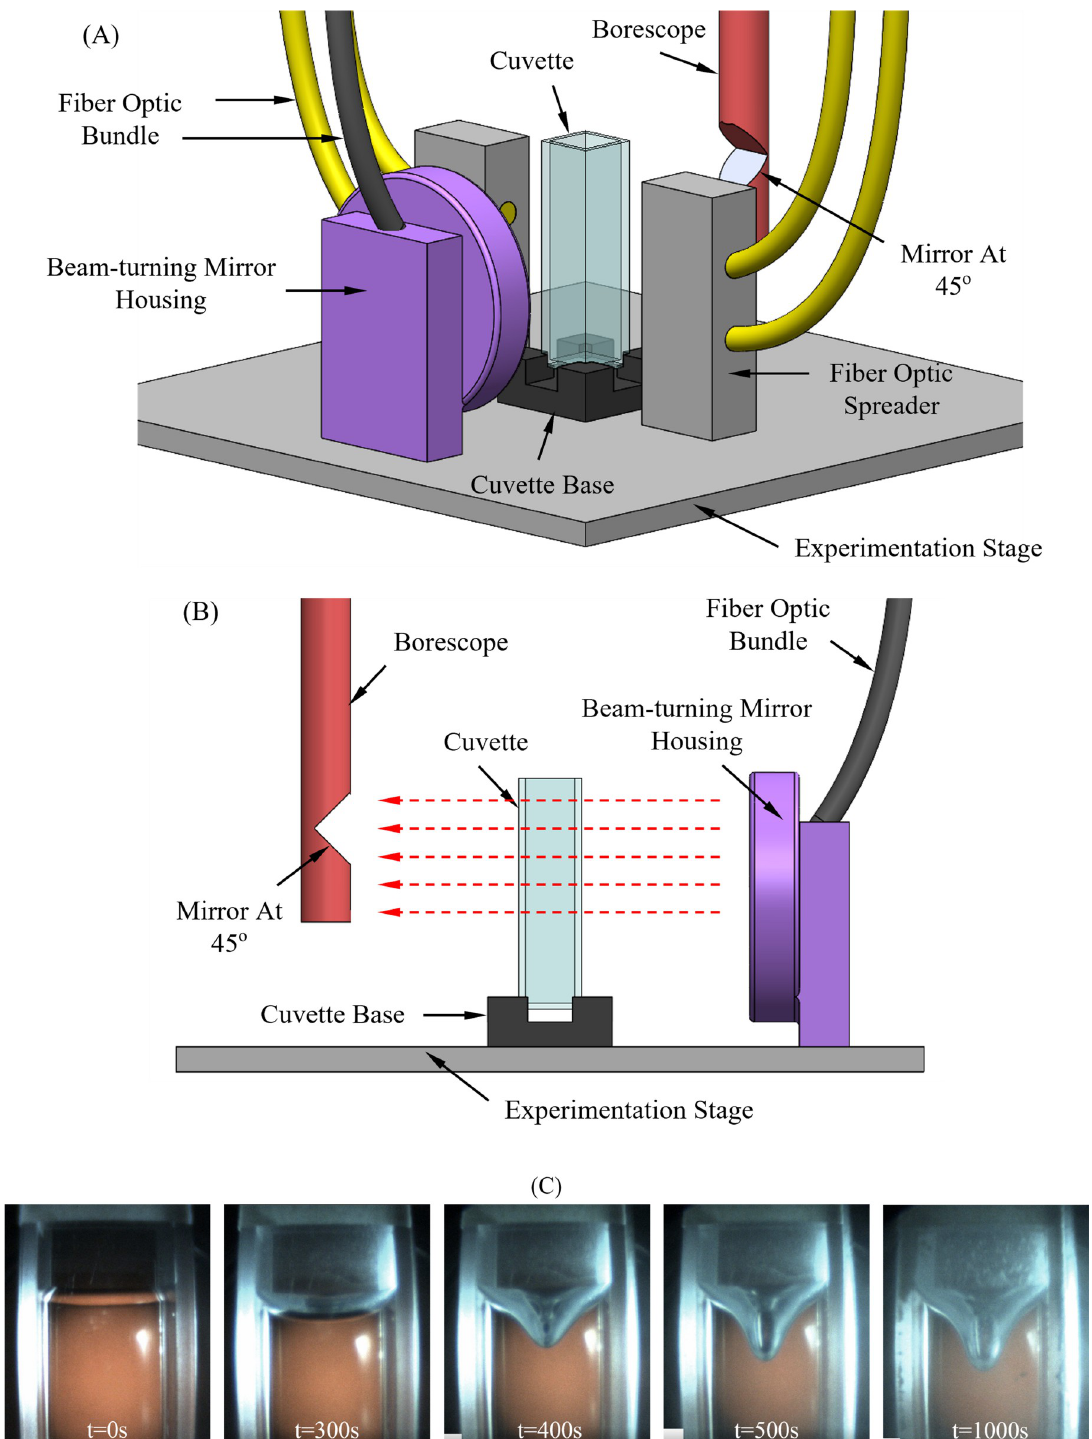
Fig 1. (A) Schematic illustration of the cryomacroscope. (B) Side view illustration showing the path of light passing through the cuvette using red arrows. (C) Selected images displaying surface deformation at various times during the vitrification process subject to a constant cooling rate of 25˚C/min from an initial temperature of 10˚C down to final temperature of -125˚C. The cuvette has outer dimensions of 12.5 mm × 12.5 mm × 45 mm, filled with 2.8 ml of 7.05M DMSO.